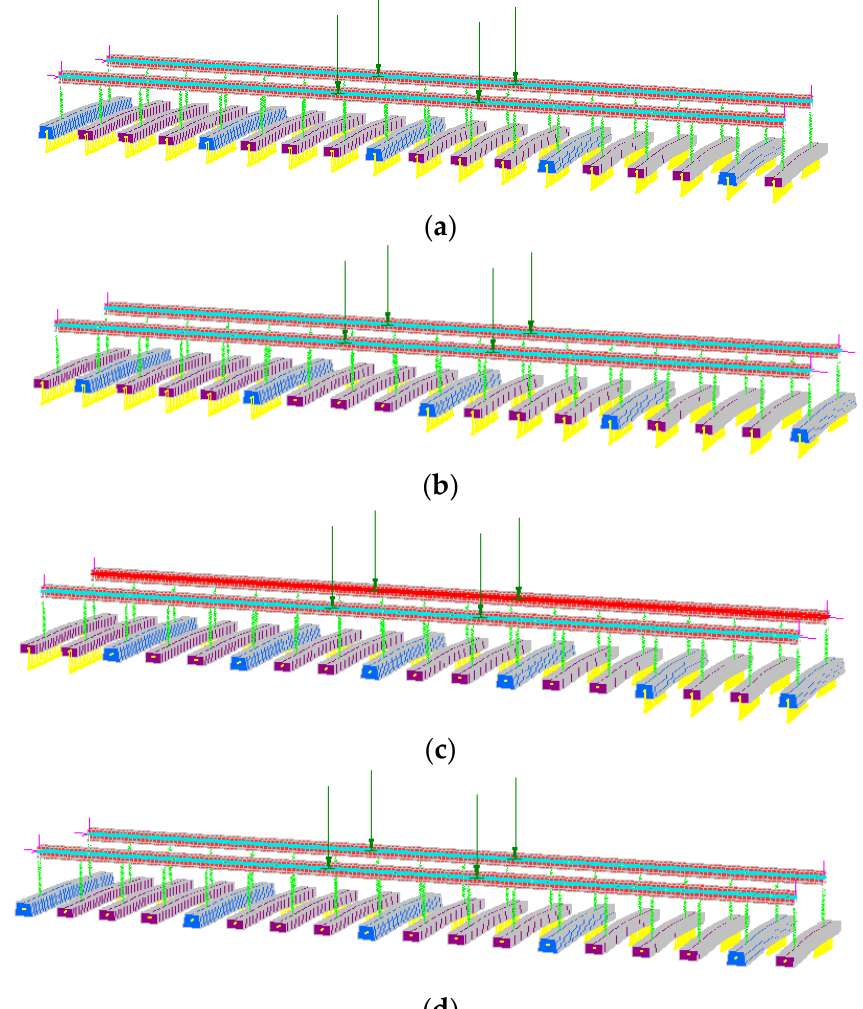
Figure 7. Different sleeper support conditions: ( a ) fully supported sleeper, ( b ) half supported sleeper and ( c ) totally unsupported sleeper.